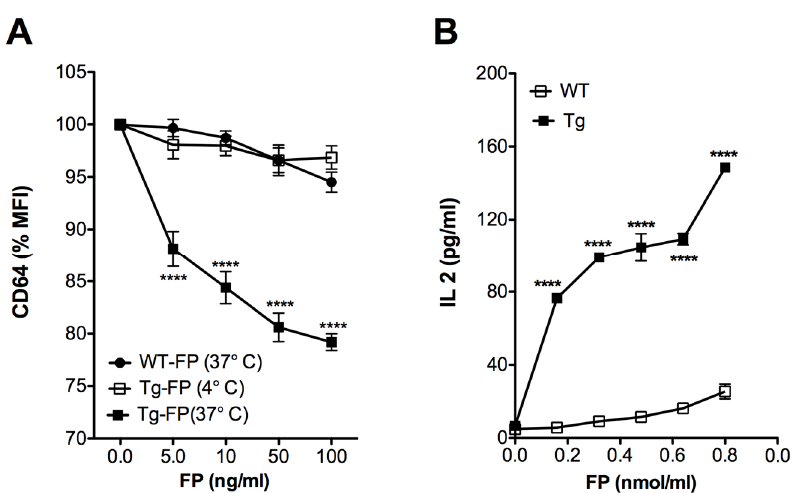
Figure 5. Human Fc γ RI targeting facilitated antigen uptake and presentation: ( A ) splenocytes from WT (wild type) and Tg (transgenic) mice were treated with the indicated amounts of Trivalent-FP at 4 ◦ C or 37 ◦ C for 2 h and stained with CD19-PE, CD11b-APC, CD11c-BV421, and anti-human and anti-mouse CD64-FITC antibodies. CD64 expression on the surface of CD19 − CD11b + CD11c + cells was evaluated by flow cytometry. Percentage change in the MFI relative to untreated cells is shown. ( B ) PspA-specific T cell hybridoma B6D2 was co-cultured with WT or Tg peritoneal exudate macrophages and treated with indicated amounts of Trivalent-FP. Then, 48 h following incubation, IL-2 levels were measured in culture supernatants by biplex assay. Mean ± SE of data from two independent experiments is shown ( n = 6 / group, **** p = 0.0001). Statistical significance between groups was evaluated by Mann–Whitney nonparametric test.